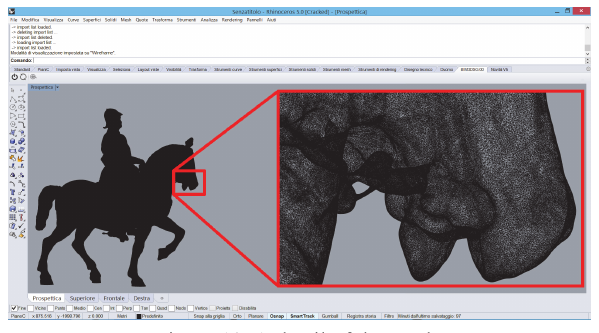
Figure 10. A detail of the mesh.